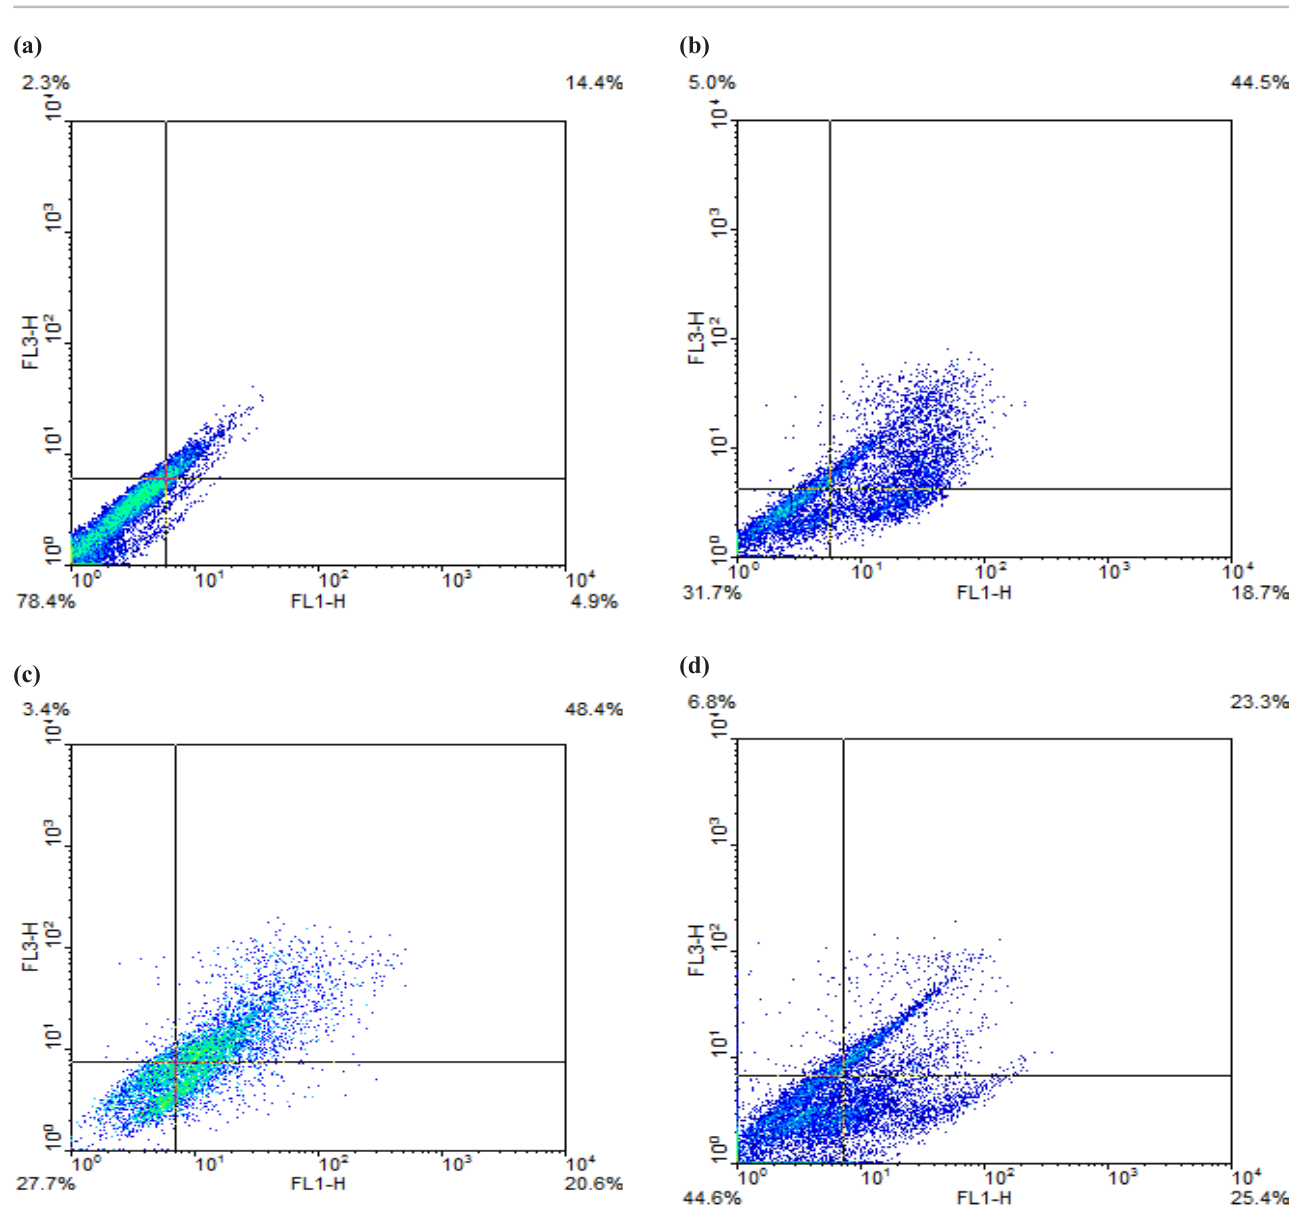
FIGURE 3 - Flow cytometry analysis of untreated (a) and treated CaCo2 cells with 10 8 CFU/ml of live (b), 30% HK ( c) and 30% CFS (d) of L.casei RTCC 1296-2